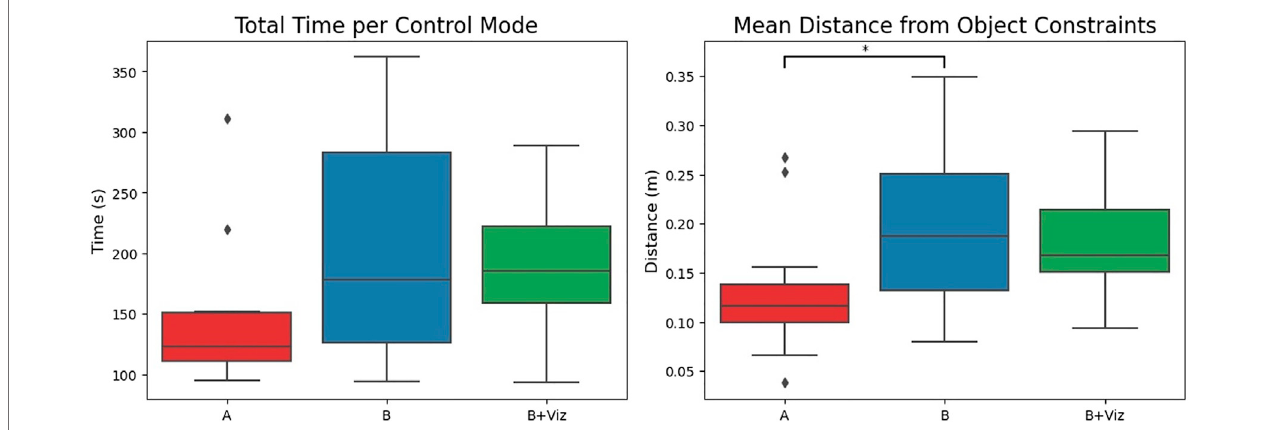
FIGURE7| Total time taken and average distancefrom environmental obstacles when completing thescrewdriver taskusing three differentcontrol modes. Direct teleoperationgarnersquickertimesthanthesharedcontrolmodes( “ B ” and “ B+Viz ” )attheexpenseofsafety,assigni fi edbythecloserproximityoftrajectoriestoobject constraints.